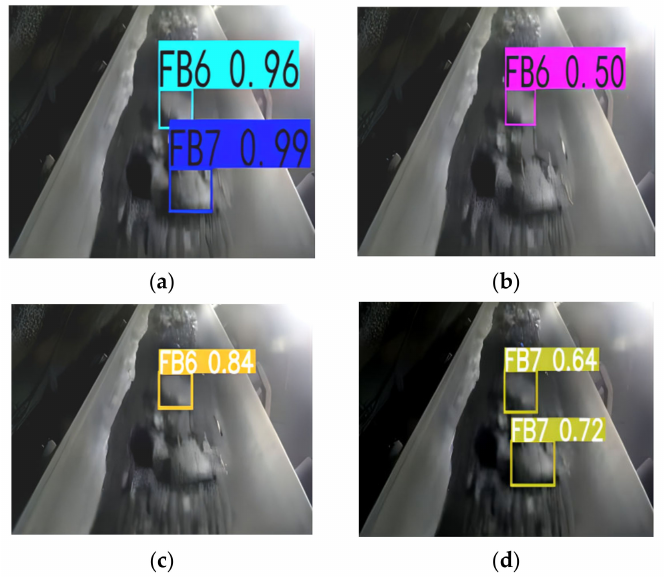
Figure 12. Recognition results of four algorithms. ( a ) Recognition results of SSD. ( b ) Recognition results of YOLOv3. ( c ) Recognition results of YOLOv5. ( d ) Recognition results of the improved YOLOv5 algorithm.